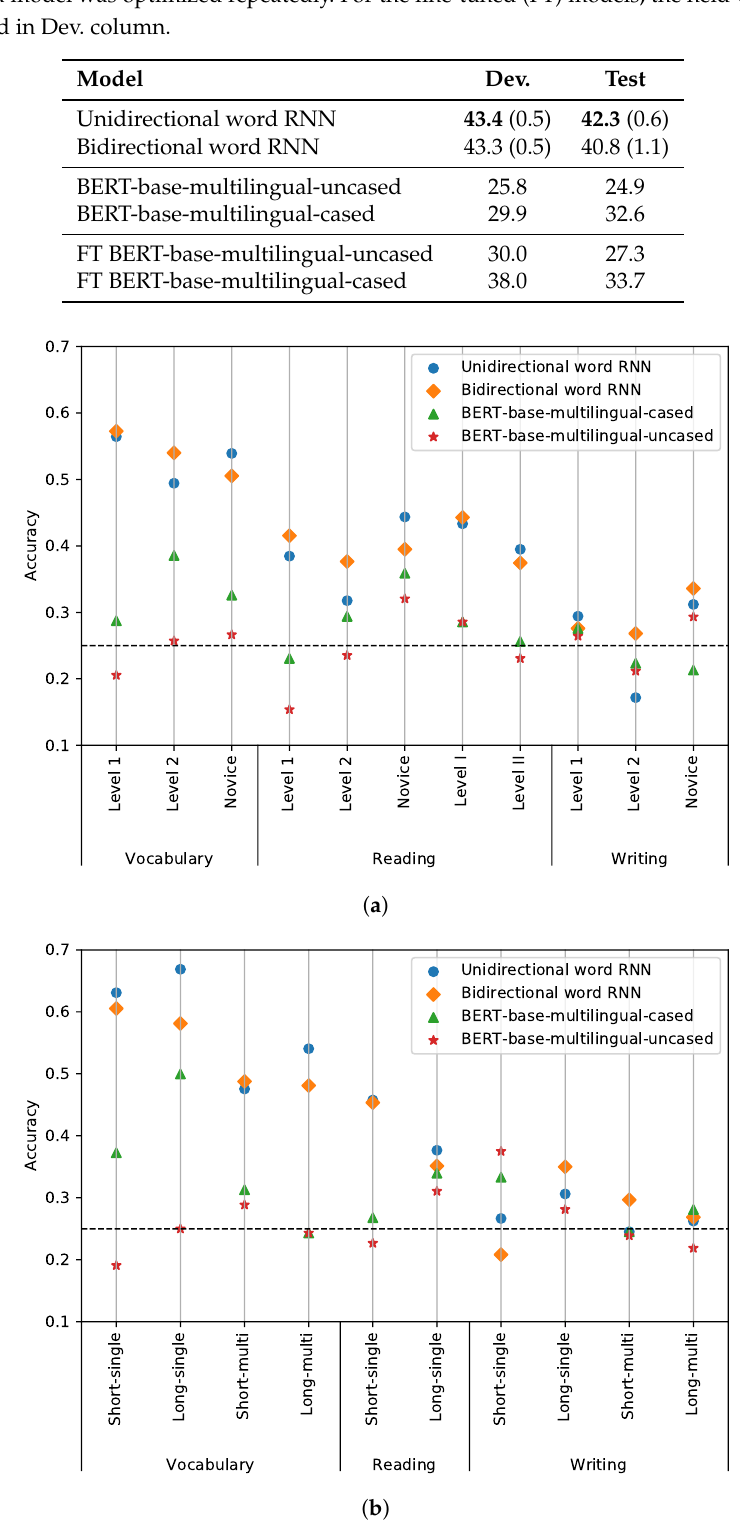
Figure 5. Performance analysis on the TOPIK set. The mean accuracies for each difficulty level and question type are shown in ( a , b ), respectively. The black dotted line signifies the accuracy of a random classifier, which equals